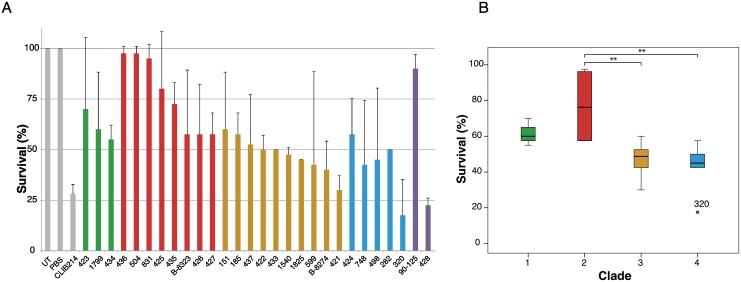
Virulence of C. orthopsilosis isolates.A. The percentage survival of Galleria mellonella 96 h after injection with 5 x 105 cells of C. orthopsilosis strains (or 1 x 106 for C. parapsilosis CLIB214) is shown. The survival assays were carried out twice, using 20 larvae per experiment. The graph shows the average and standard deviation of the percent surviving larvae at the endpoints from the two independent experiments. Columns from left to right represent: untreated control (UT), phosphate-buffered saline injected larvae (PBS), C. parapsilosis CLIB214, isolates from Clade 1 (green bars), Clade 2 (red), Clade 3 (orange), Clade 4 (blue), homozygous isolates 90–125 and 428 (purple). B. The endpoint survival rates between the clades were compared using ANOVA. When the two experiments are combined (i.e. 40 larvae infected with each isolate), Bonferroni multiple comparison correction showed that there is significant difference in survival between the strains in Clades 2 and 3 (p = 0.001) and between Clades 2 and 4 (p = 0.001). Considering each experiment individually, the p-values are marginally significant; p = 0.003 and 0.075 for Clade 2 versus 3, and p = 0.004 and 0.095 for Clade 2 versus 4.